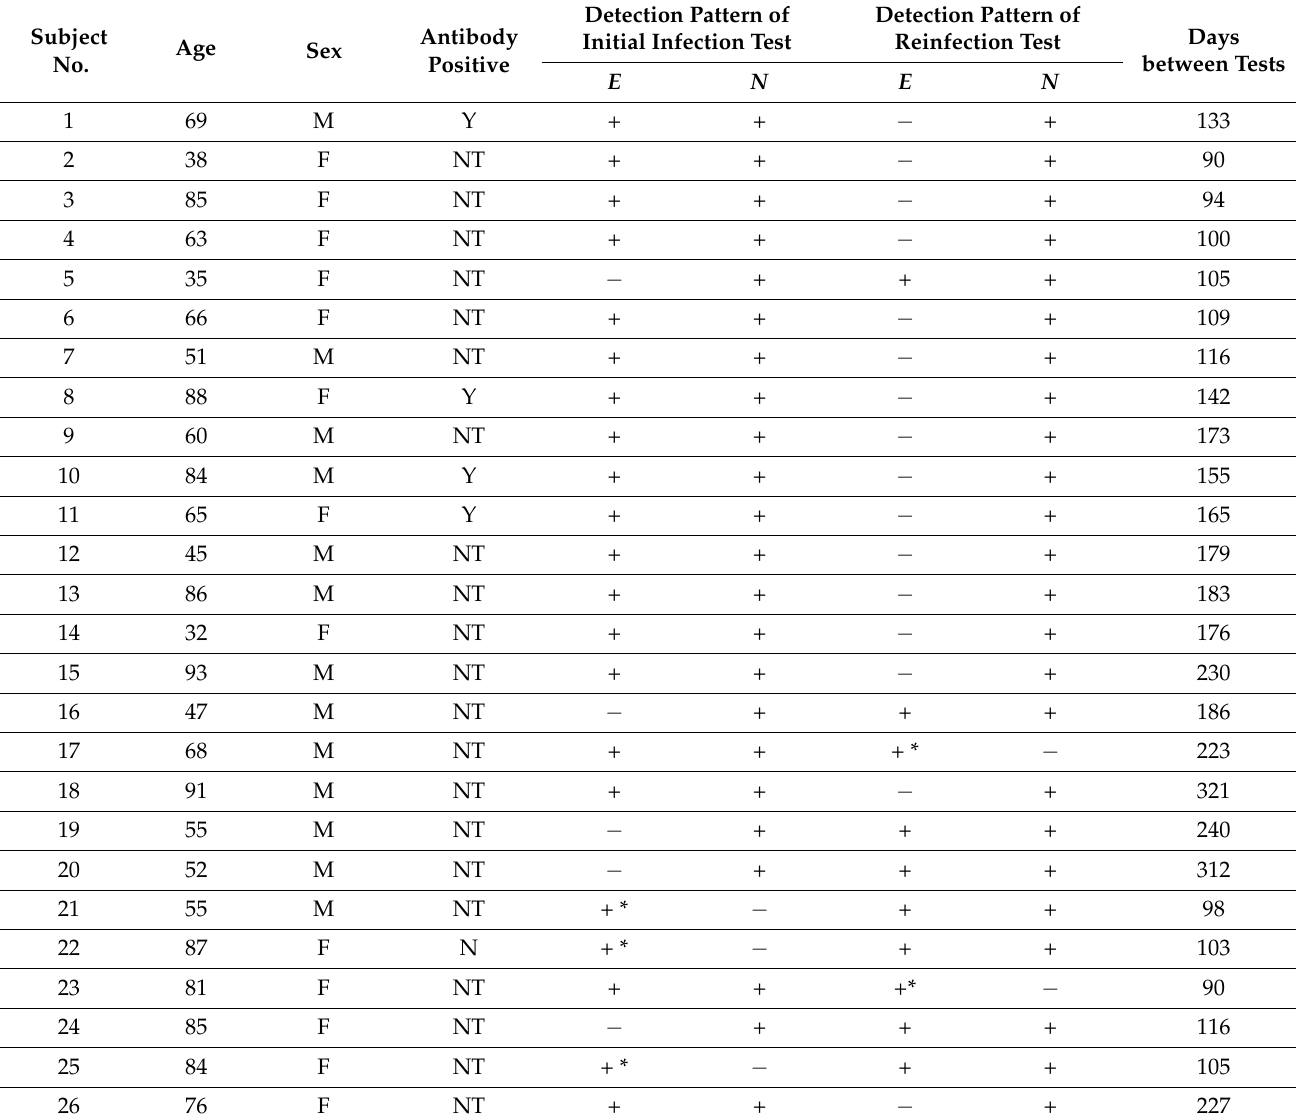
Table 1. Changes in multiplex RT-PCR detection